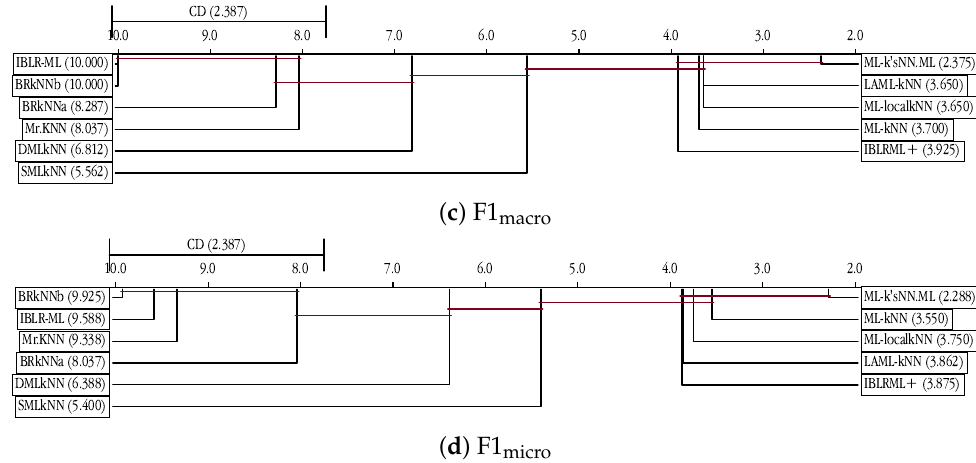
Figure 8. Nemenyi test for the different variants of ML-kNN and the different classification metrics.